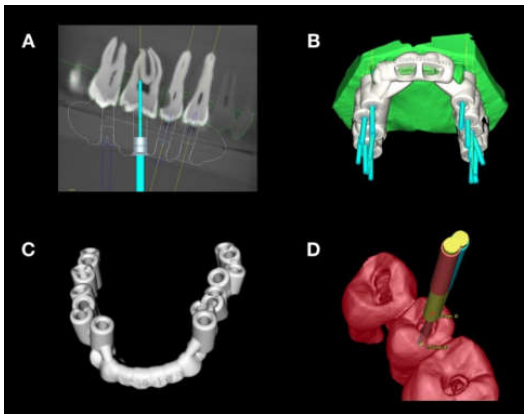
Figure 1. Digital workflow: ( A ) virtually planned straight-line access cavity, ( B ) multiple access cavities planned for posterior teeth in a maxillary model, ( C ) virtually designed template, ( D ) 3D rendered view of accuracy evaluation revealing the deviation between planned and performed access cavity preparation.